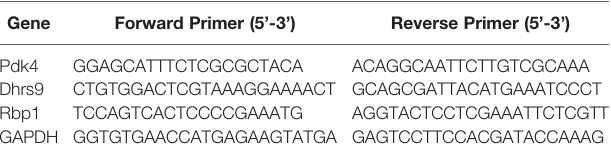
TABLE 1 | Primer sequences for real-time